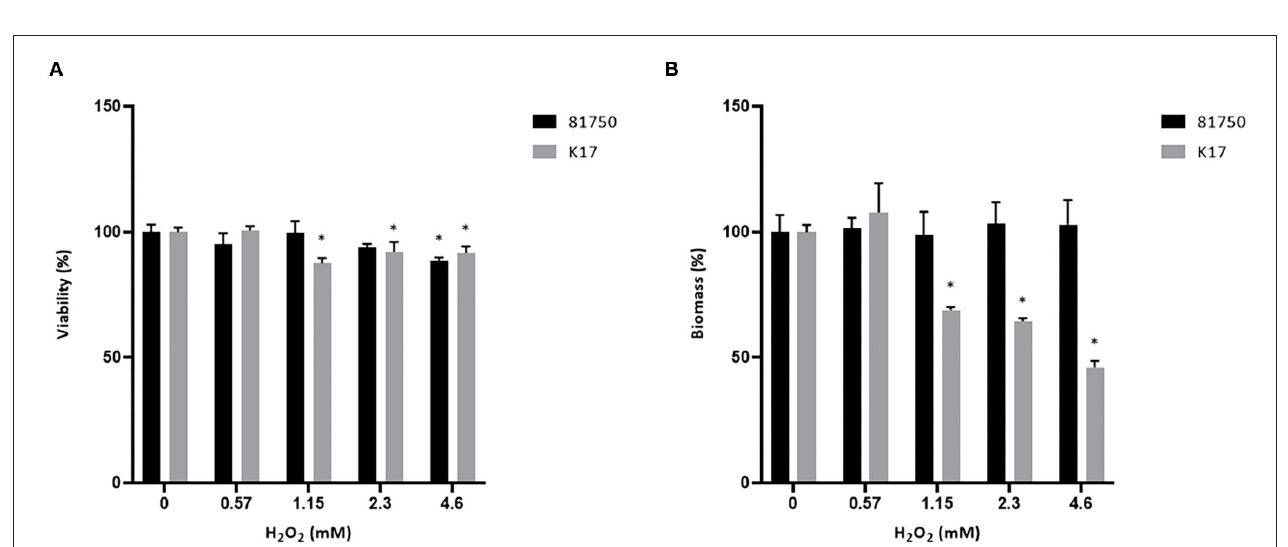
FIGURE 3 | Effect of H 2 O 2 at the minimal bactericidal concentration (A) and a culture supernatant of S. pluranimalium 2N12 treated or not with catalase (B) on the killing of planktonic cells of A. pleuropneumoniae 81750 and K17. Bacterial viability was assessed by determining colony-forming units (CFU) after an exposure time of 4h. The broken horizontal line indicates the minimum detection limit (10 1 CFU/mL). Assays were performed in triplicate in three independent experiments, and the means ± SD were calculated. *Significantly different at p < 0.01 compared to the control (no H 2 O 2 or no S. pluranimalium culture supernatant).